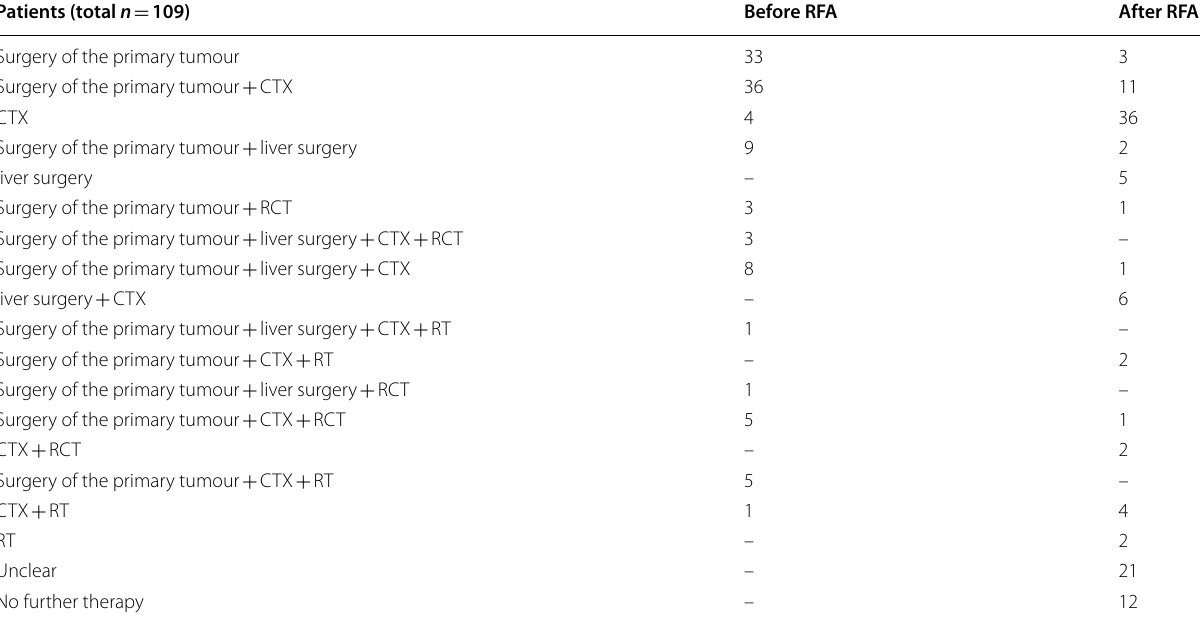
CTX chemotherapy, RCT radiochemotherapy, RT radiotherapy